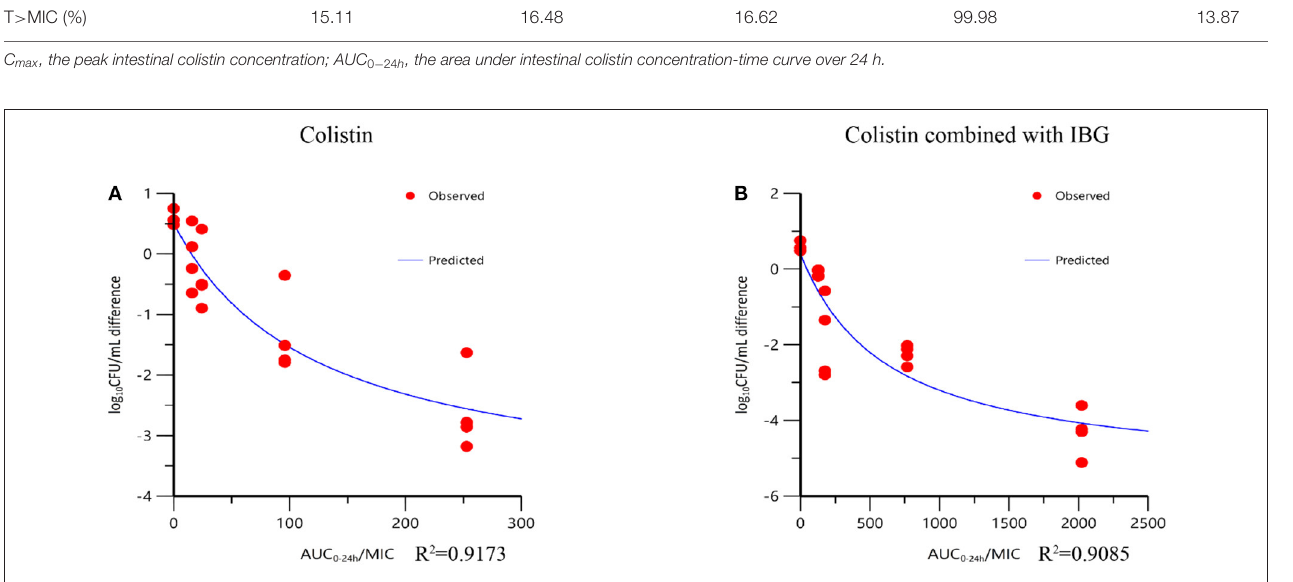
FIGURE 3 | Relationships between the effect of colistin against mcr-1 -positive Salmonella and the PK/PD indices AUC 0 − 24h /MIC in the intestinal infection model. R 2 is the coefficient of